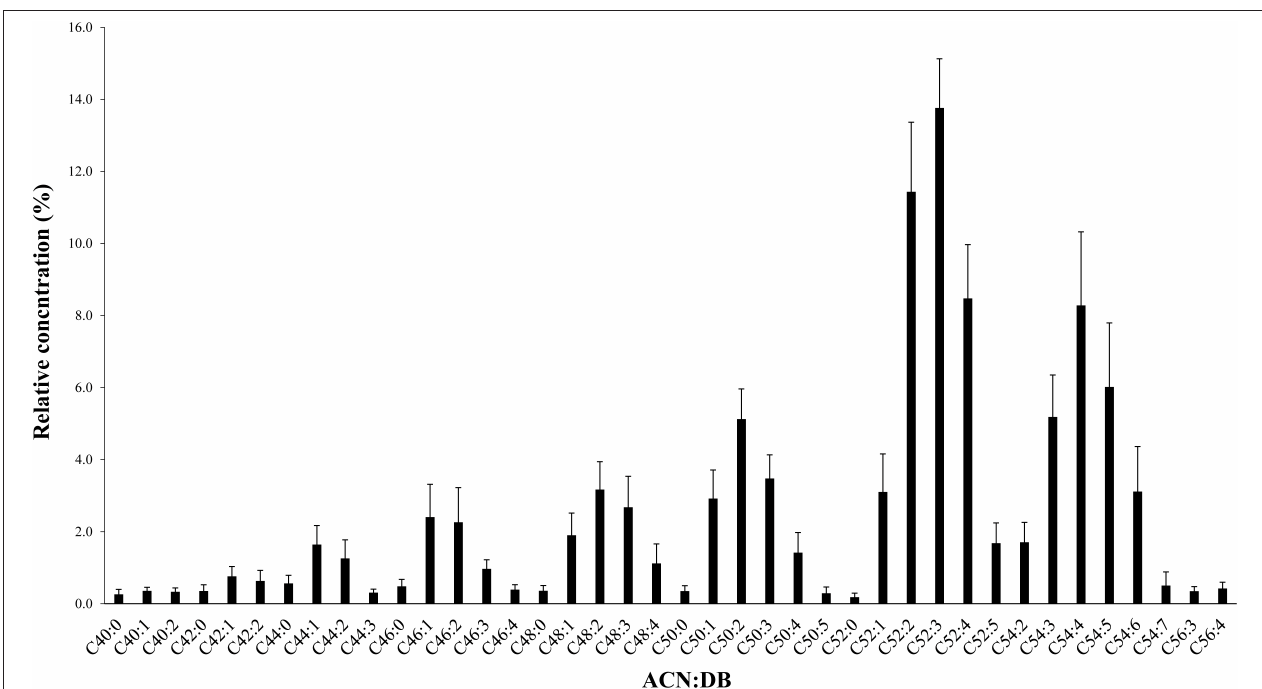
FIGURE 1 | Molecular weight distribution of triacylglycerols (TAGs) with relative concentration (percent area) in breast milk. TAGs are presented as ACN:DBs (acyl carbon number:number of double bonds). Values are the relative concentration plus standard deviation of all breast milk TAGs. ACN:DB appears in the order of increasing molecular weight.